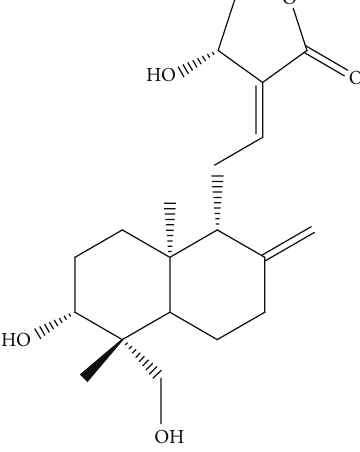
Figure 1: Chemical structure of andrographolide